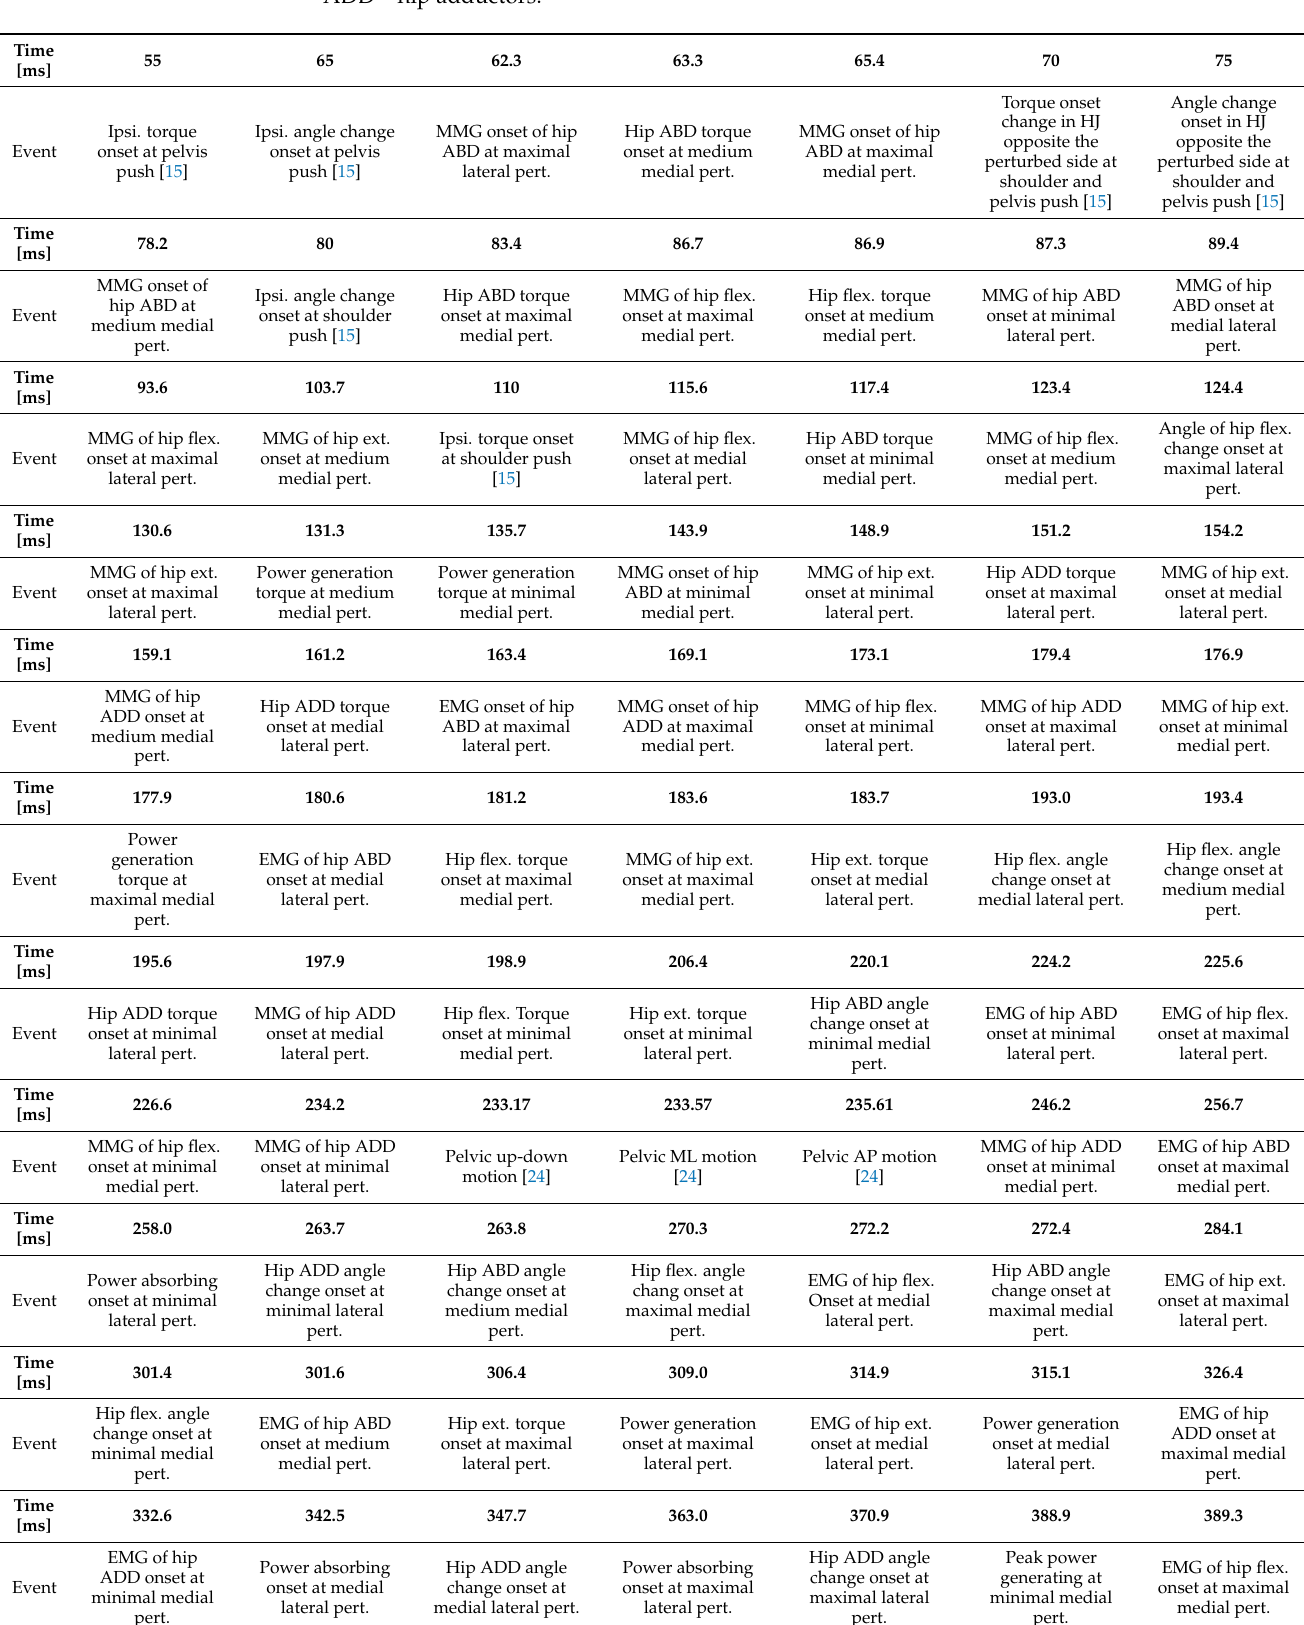
Table A3. A detailed description of the temporal reactions to mediolateral perturbations in the pelvis and hip joint (HJ). The provided data are mainly from the paper [20], where: ABD—hip abductors, ADD—hip